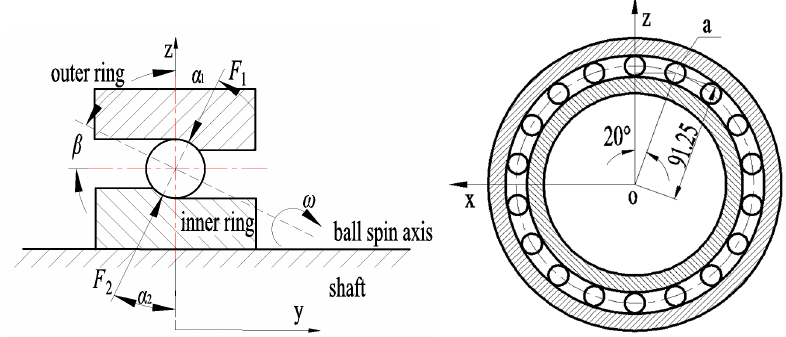
Figure 11. Schematic diagram of geometric parameters of the ball.